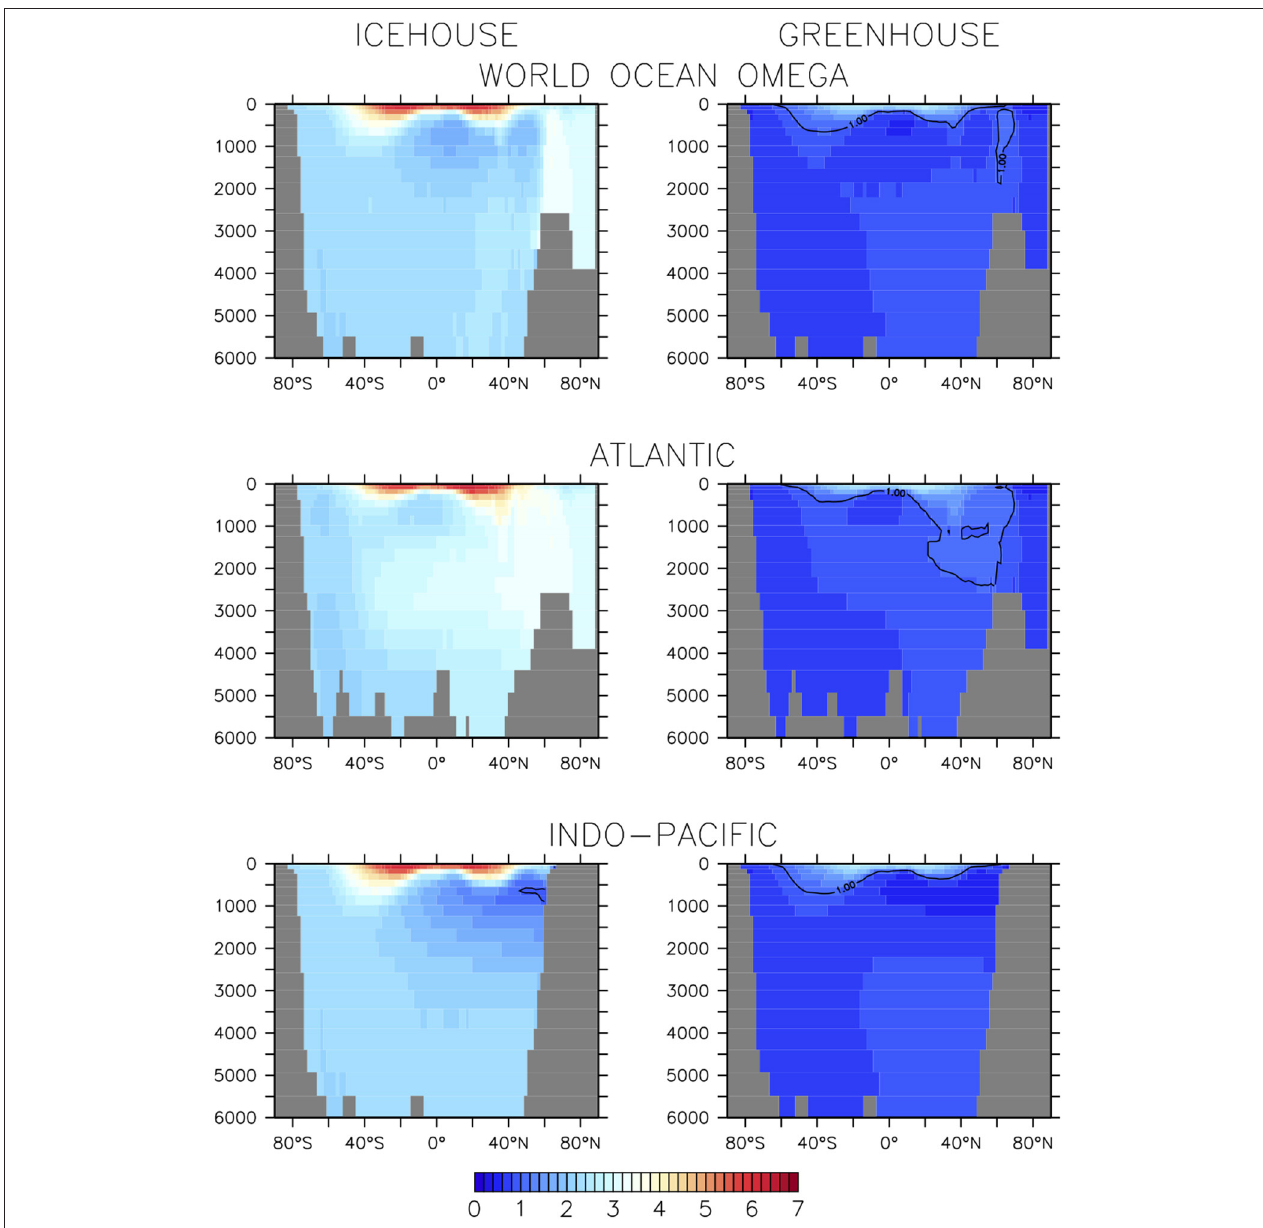
FIGURE 3 | Basin-averaged calcite saturation state in icehouse (left column) and greenhouse (right column)